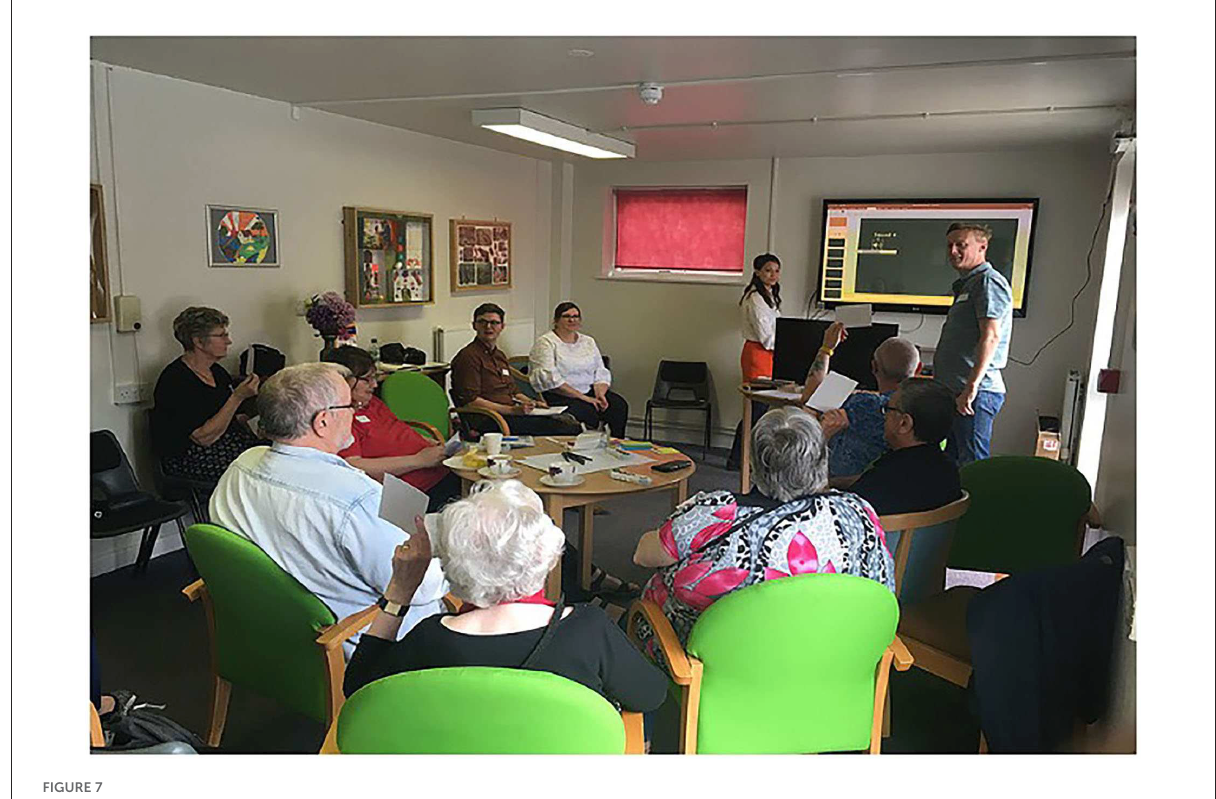
FIGURE7 Co-creation workshop.